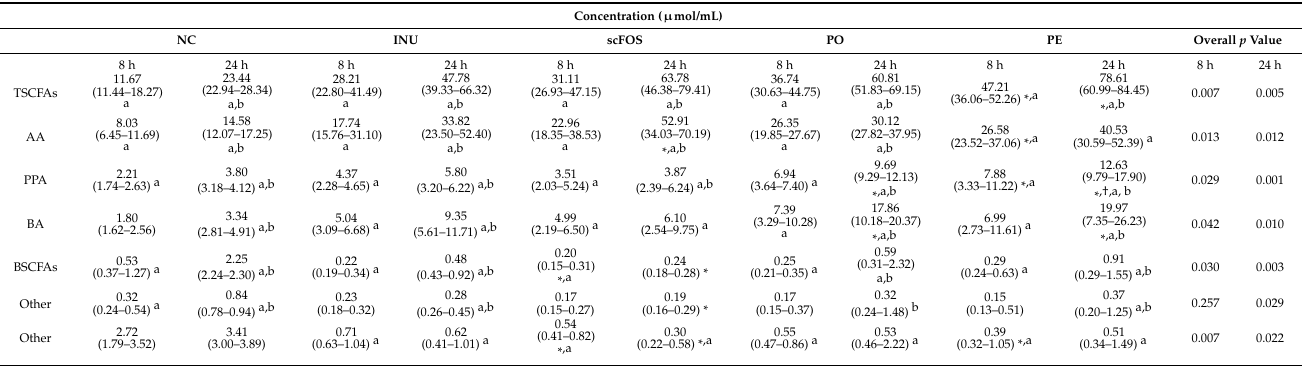
Table 7. Total short-chain fatty acids (TSCFAs) and SCFAs concentrations ( µ mol mL − 1 of sample) after 8 and 24 h of fermentation for the ASD children group.